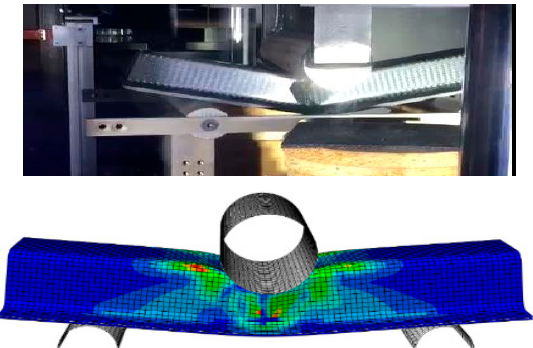
Figure 7. Experimental and Finite element dynamic loading.